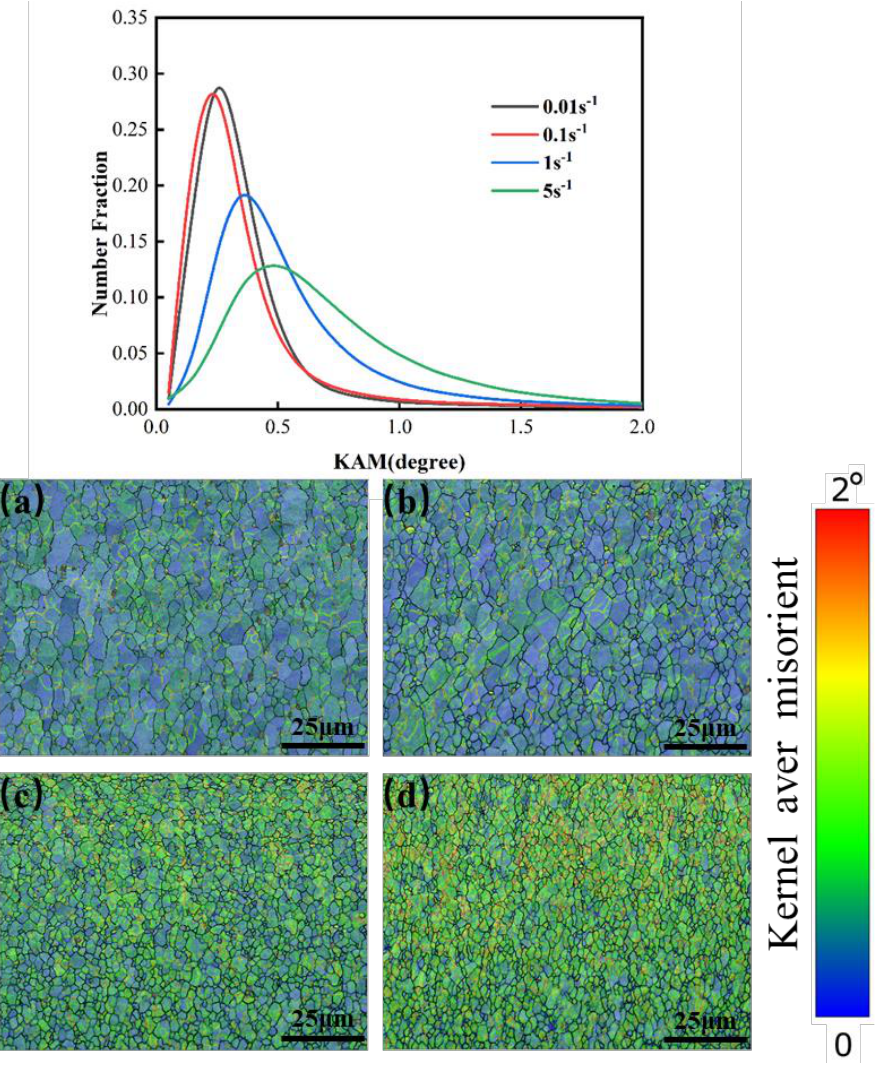
Figure 22. KAM maps of Mo − 1.5wt%ZrO 2 molybdenum alloy at a temperature of 1200 °C: ( a ) 0.01 s −1 , ( b ) 0.1 s −1 , ( c ) 1 s −1 , ( d ) 5 s −1 .